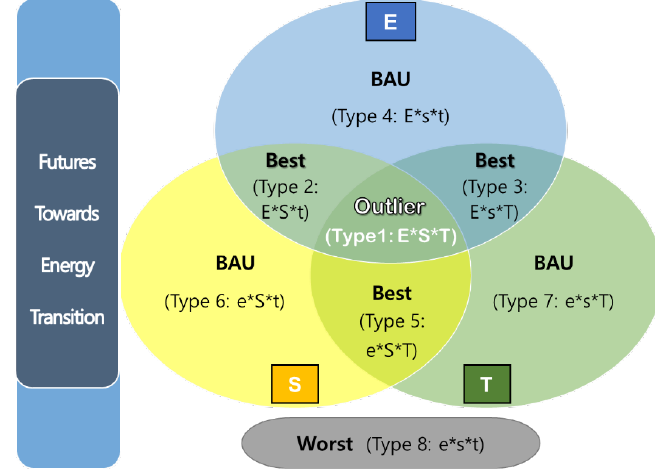
Figure 1. Diagram of four futures scenarios based on the eight ideal types of energy transition.